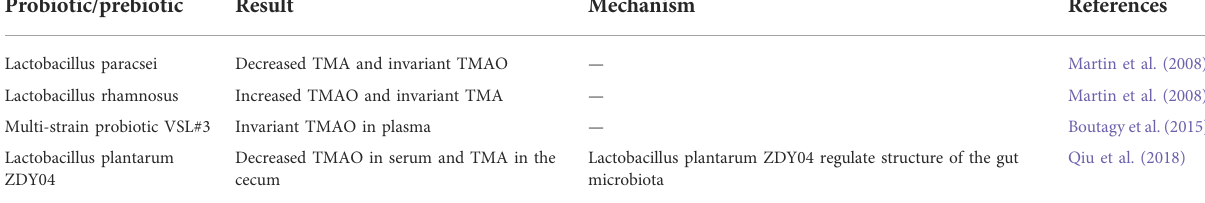
TABLE 1 Probiotic/prebiotic that effect TMAO